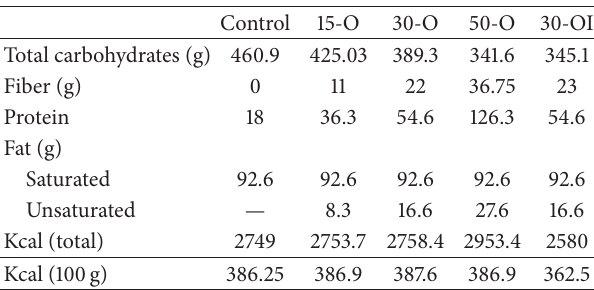
Table 3: Total caloric